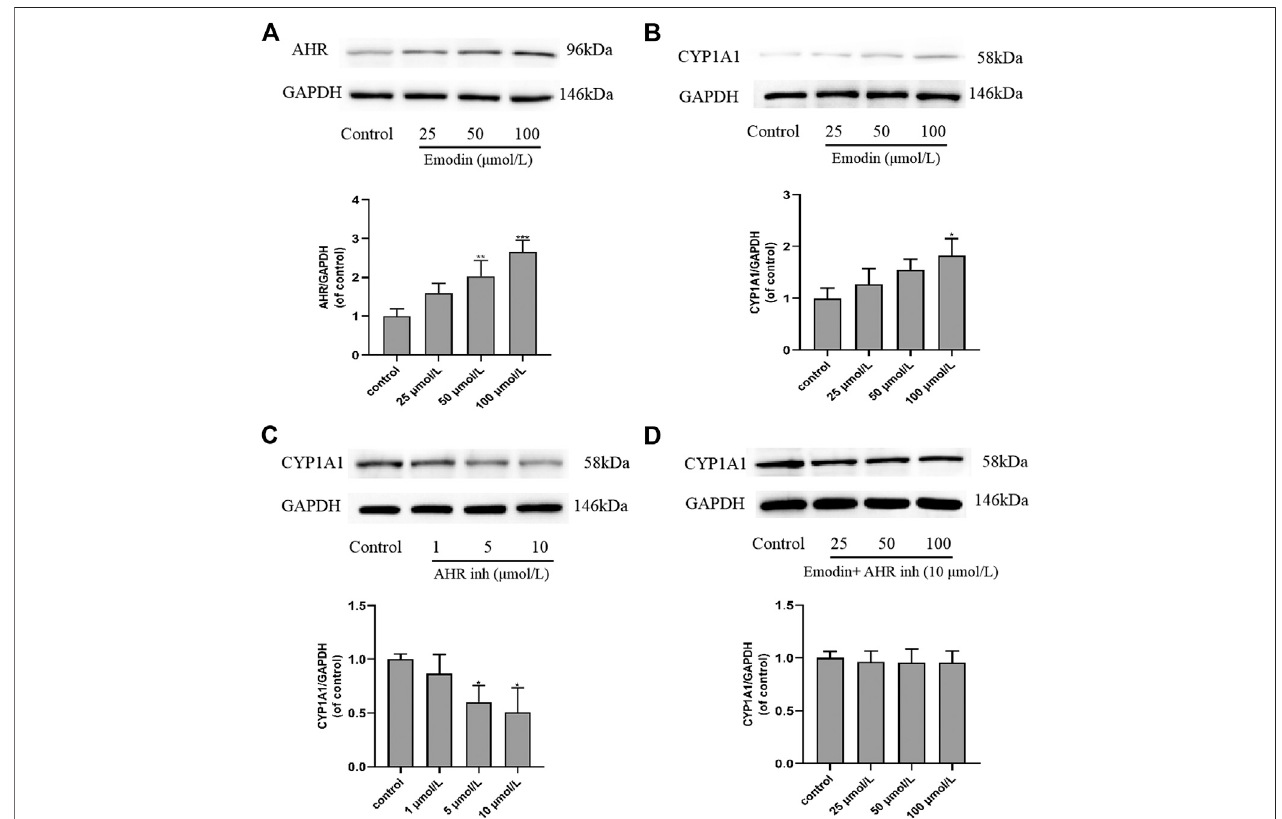
FIGURE 7 | Effects of emodin and AhR inhibitor CH223191 on the protein expression levels of AhR and CYP1A1 in MCF-7 cells (mean ± SD, n (cid:2) 3) (A) In the cells treatedwithemodin,theexpression ofAhR protein using GAPDH asaloadingcontrol and thegraphicalrepresentations oftheAhR/GAPDHratio; (B) In thecells treated withemodin,theexpressionofCYP1A1proteinusingGAPDHasaloadingcontrolandthegraphicalrepresentationsoftheCYP1A1/GAPDHratio; (C) Inthecellstreated with CH223191, the expression of CYP1A1 protein using GAPDH as a loading control and the graphical representations of the CYP1A1/GAPDH ratio; (D) In the cellsintervenedwithemodinand10 μ mol/LofCH223191, theexpressionofCYP1A1proteinusingGAPDHasaloadingcontrolandthegraphicalrepresentationsofthe CYP1A1/GAPDH ratio.